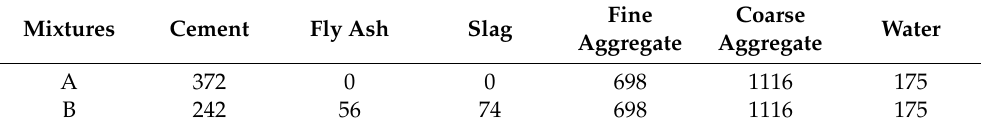
Table 1. Mixture compositions (kg/m 3